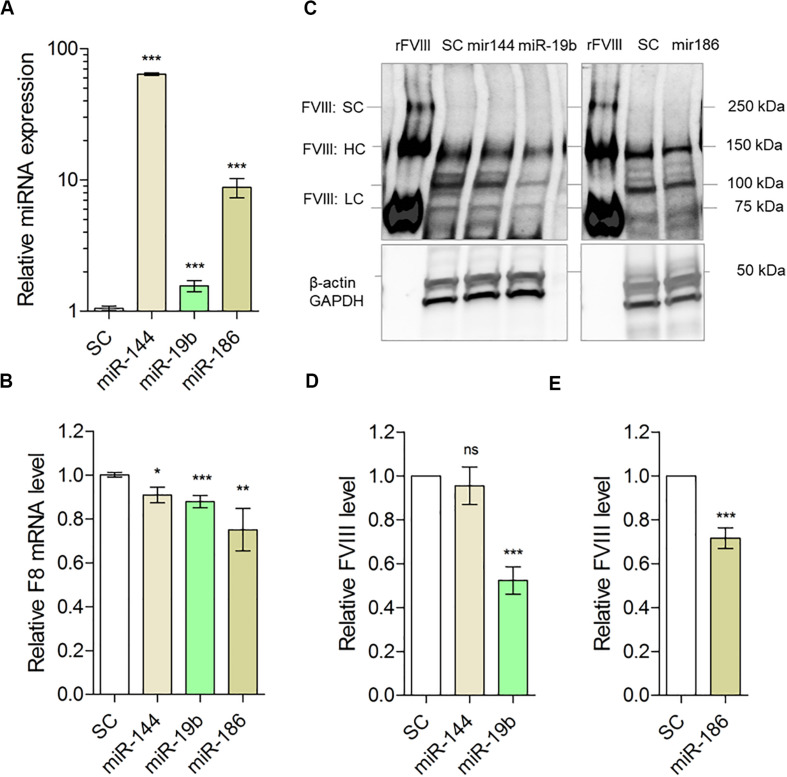
Predicted miRNAs can target F8 and downregulate FVIII expression in mammalian cells. (A) Relative overexpression of miRNAs (scrambled control: SC = 1.035 ± 0.026, N = 14; miR-144 = 64.00 ± 1.54, N = 6; miR-19b = 1.562 ± 0.154, N = 6; miR-186 = 8.790 ± 1.468, N = 8) and (B) relative expression of F8 mRNA (SC = 1.004 ± 0.019, N = 16; miR-144 = 0.9089 ± 0.0354, N = 12; miR-19b = 0.879 ± 0.028, N = 12; miR-186 = 0.751 ± 0.073, N = 12) in LCL cells transfected with miRNAs expression vectors compared to control cells (scrambled control, SC). Q-PCR results of miRNAs and F8 were normalized to RNU6 and GAPDH, respectively. (C) Relative FVIII level in LCL cells collected 72 h after transfection with miRNAs: miR-144, miR-19b, and miR-186 expression vectors compared to control cells (SC) determined by Western blot from transfected samples along with recombinant FVIII (rFVIII). Multiple species were detected: Single chain FVIII (FVIII:SC) at about 267 kDa, heavy chain polypeptides (FVIII:HC) generated after FVIII single chain cleavage within the B domain with apparent MW range between 90 and 200 kDa; light chain (FVIII:LC) with apparent MW of 80 kDa and loading controls; and β-actin and GAPDH detected at approximately 42 and 35 kDa, respectively. The blots were cropped to improve clarity of the results. Full-length blots are presented in Supplementary Figure S3. (D) Quantification of FVIII heavy chain in cells transfected with miR-144 and miR-19b (SC = 1.011 ± 0.0127, N = 8; miR144 = 0.955 ± 0.085, N = 8; miR-19b = 0.523 ± 0.0623, N = 8) from (C). (E) Quantification of FVIII heavy chain in cells transfected with miR-186 (SC = 0.989 ± 0.0472, N = 8; miR186 = 0.717 ± 0.002, N = 8) from (C). Bands normalized to β-actin and GAPDH. *P < 0.05; **P < 0.01; ***P < 0.001.